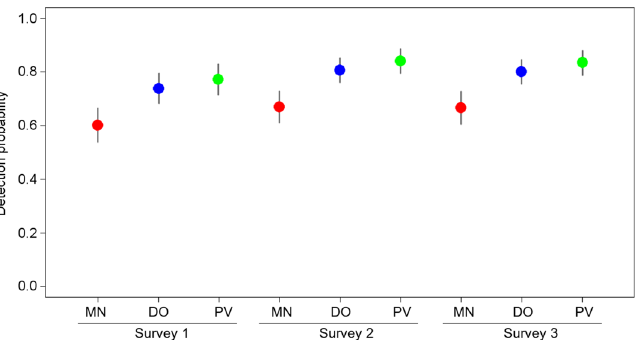
Figure 2. Model-averaged detection estimates of 36 bird species recorded in pond surveys in south-eastern Spain. Probabilities are averaged by sampling method and survey occasion. Vertical lines represent 95% confidence intervals. The three sampling methods are indicated: MN mist netting, DO direct observation, PV direct observation plus video monitoring. Surveys 1, 2 and 3 correspond to visits made in early-mid spring, late spring and early summer, respectively. The figure was created in R (version 4.0.2, https ://www.R-proje ct.org/) and assembled with GIMP (version 2.10.14, https